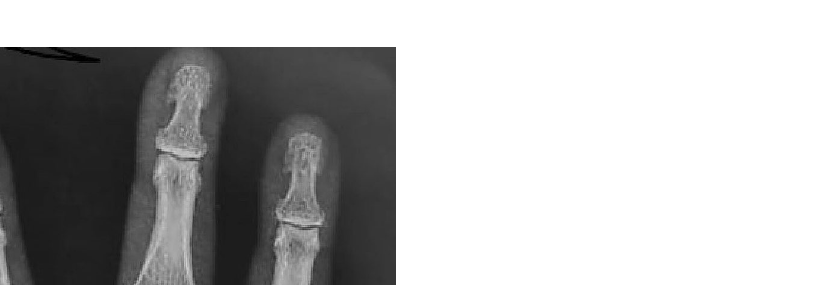
Figure 2. Plain X ray hand PA view shows mild subperiosteal bone resorption affecting radial aspects of the proximal and middle phalanges of the 2nd and 3rd fingers, terminal tuft erosions (acro-osteolysis), as well as spur-like excrescences.